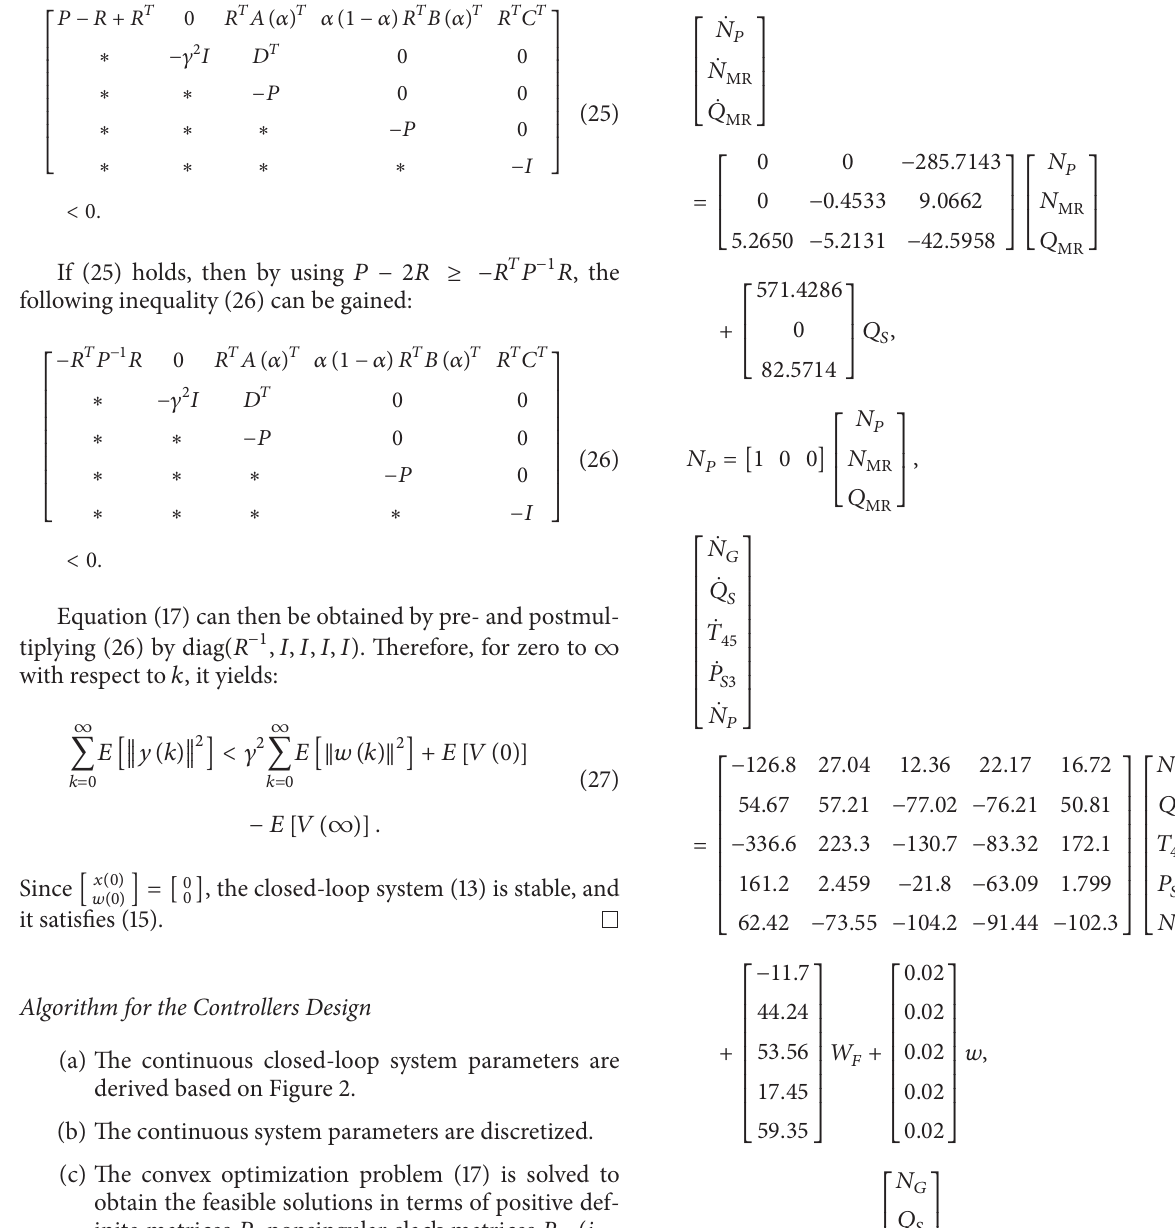
Algorithm for the Controllers